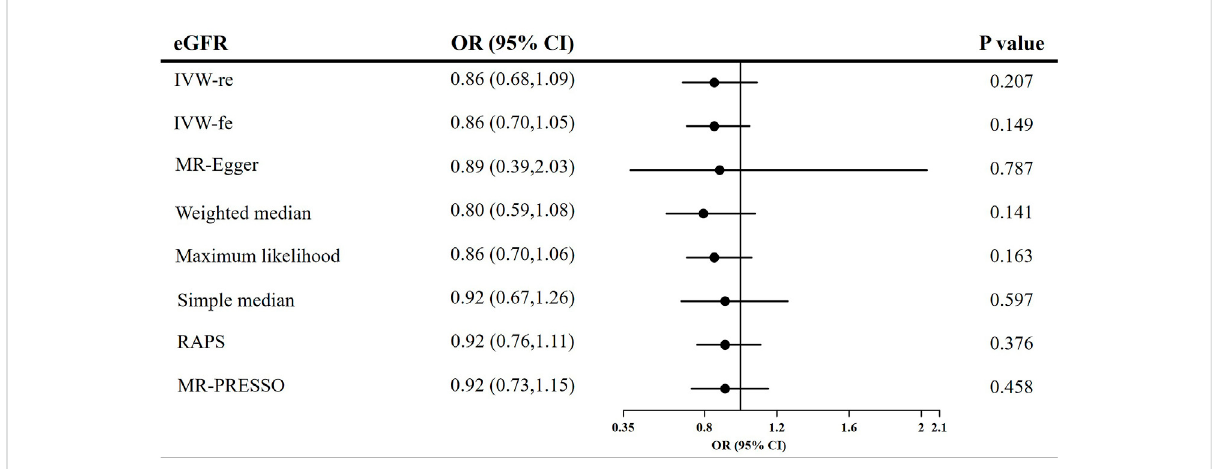
FIGURE 5 Causal estimates of eGFR on adiponectin in single-variable MR. OR, odds ratio; CI, con fi dence interval; eGFR, estimated glomerular fi ltration rate; IVW, Inverse variance weighted method; RAPS, robust adjusted pro fi le score; MR, Mendelian randomization; PRESSO, pleiotropy residual sum and